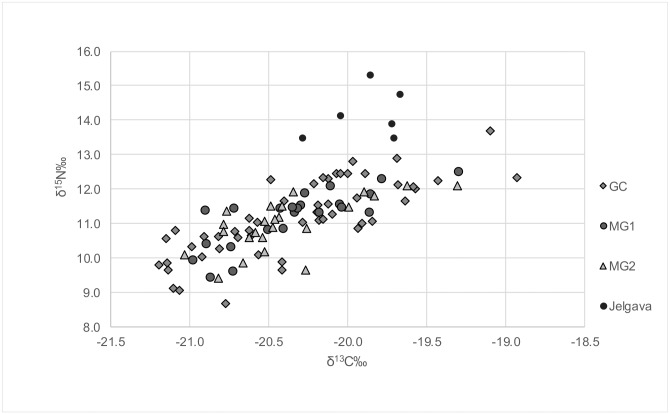
δ13C and δ15N values in the St Gertrude and Jelgava populations.